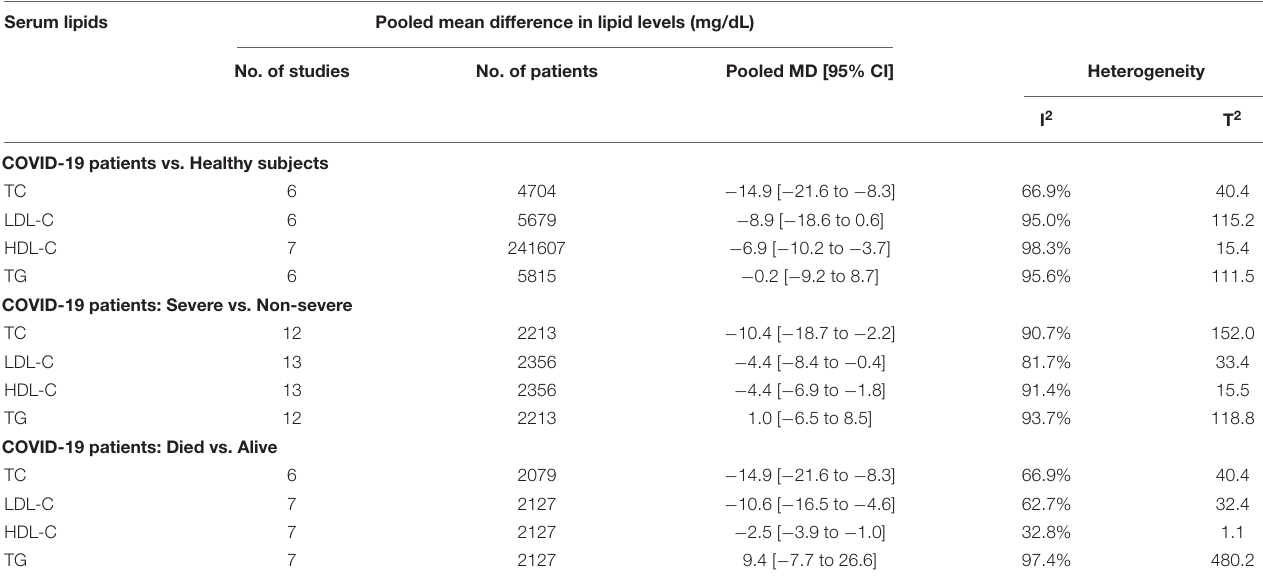
TABLE 1 | Association of lipid levels with COVID-19 infection, disease severity and mortality. Serum